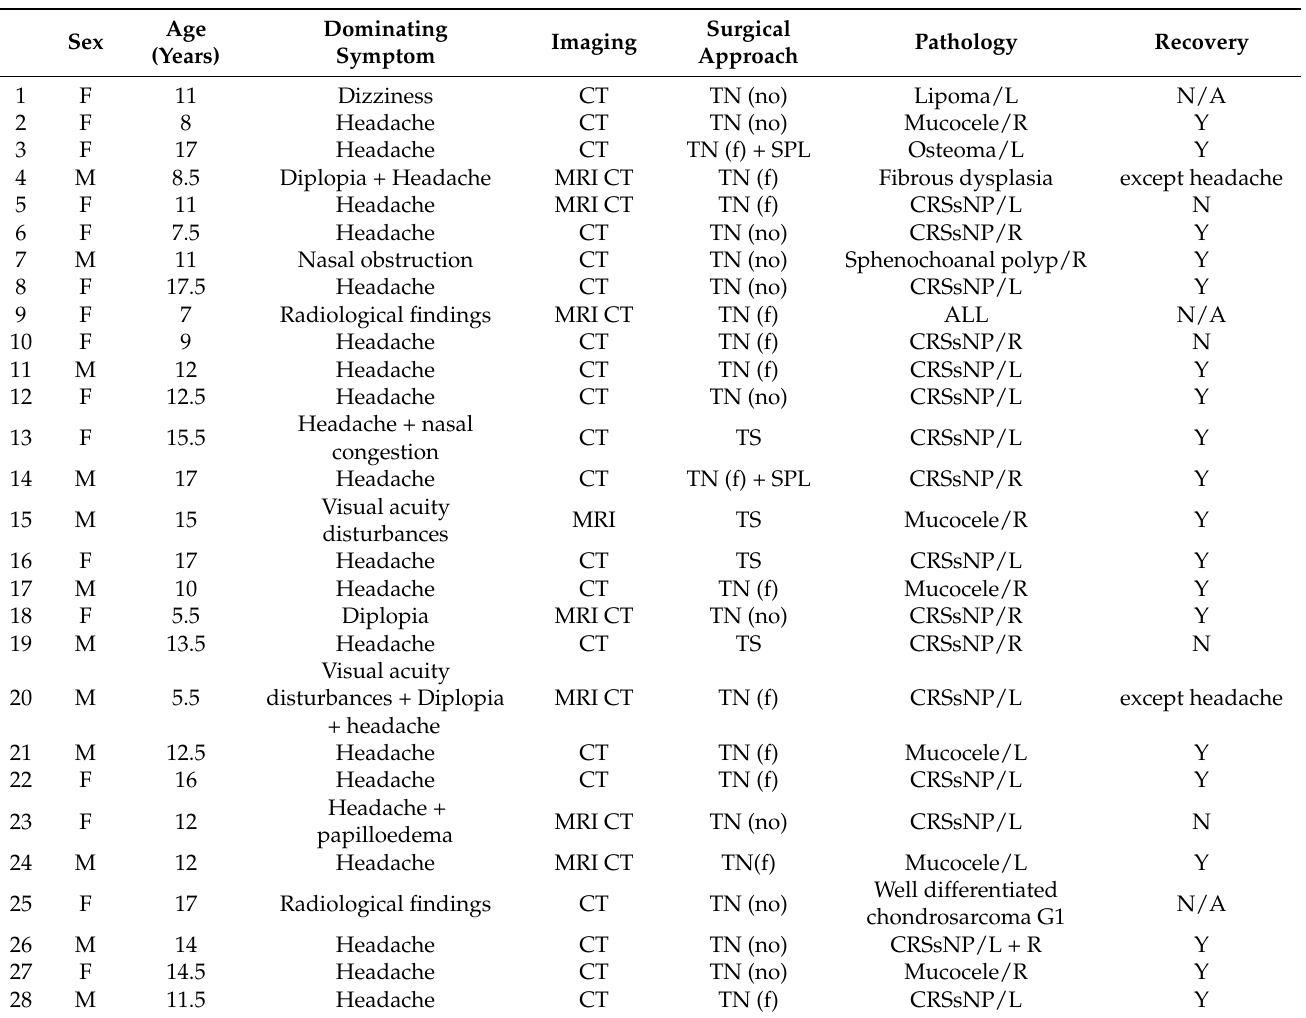
Table 1. Characteristics of the study